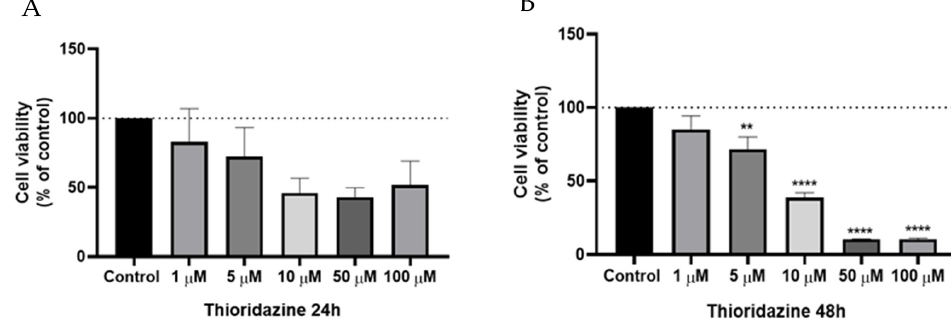
Figure 11. Effect of thioridazine exposure over ( A ) 24 h and ( B ) 48 h, on the cell viability (% of control) of MCF-7 cells, based on four independent experiments (n = 4). Results are expressed as mean ± standard error of the mean (SEM). ** p < 0.01, **** p < 0.0001. The dose-response curve was obtained for 48 h and the IC50 value calculated was